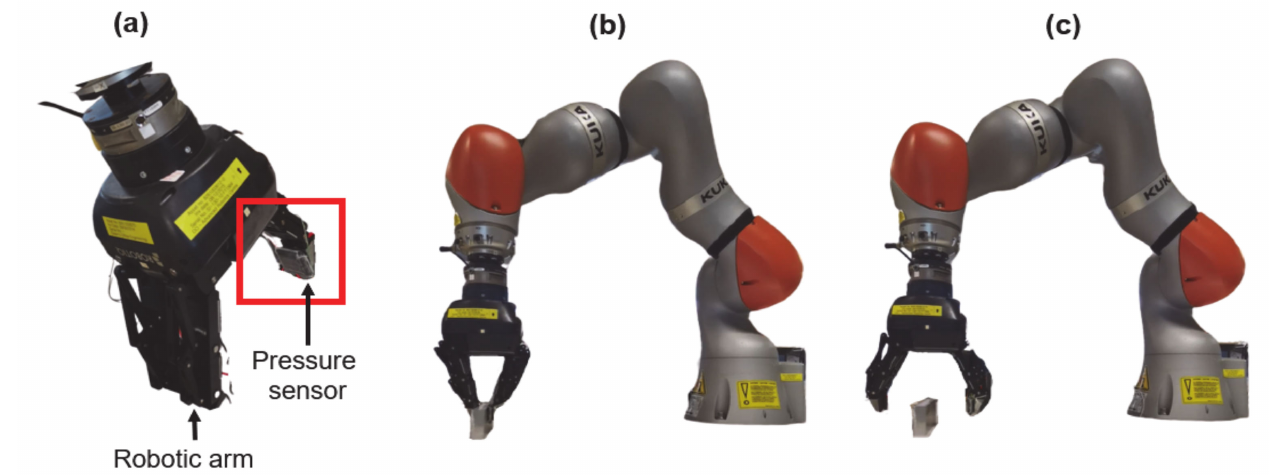
Figure 8. ( a ) Pressure sensor attached to the robotic arm; robotic arm ( b ) grab and( c ) release mechanism.